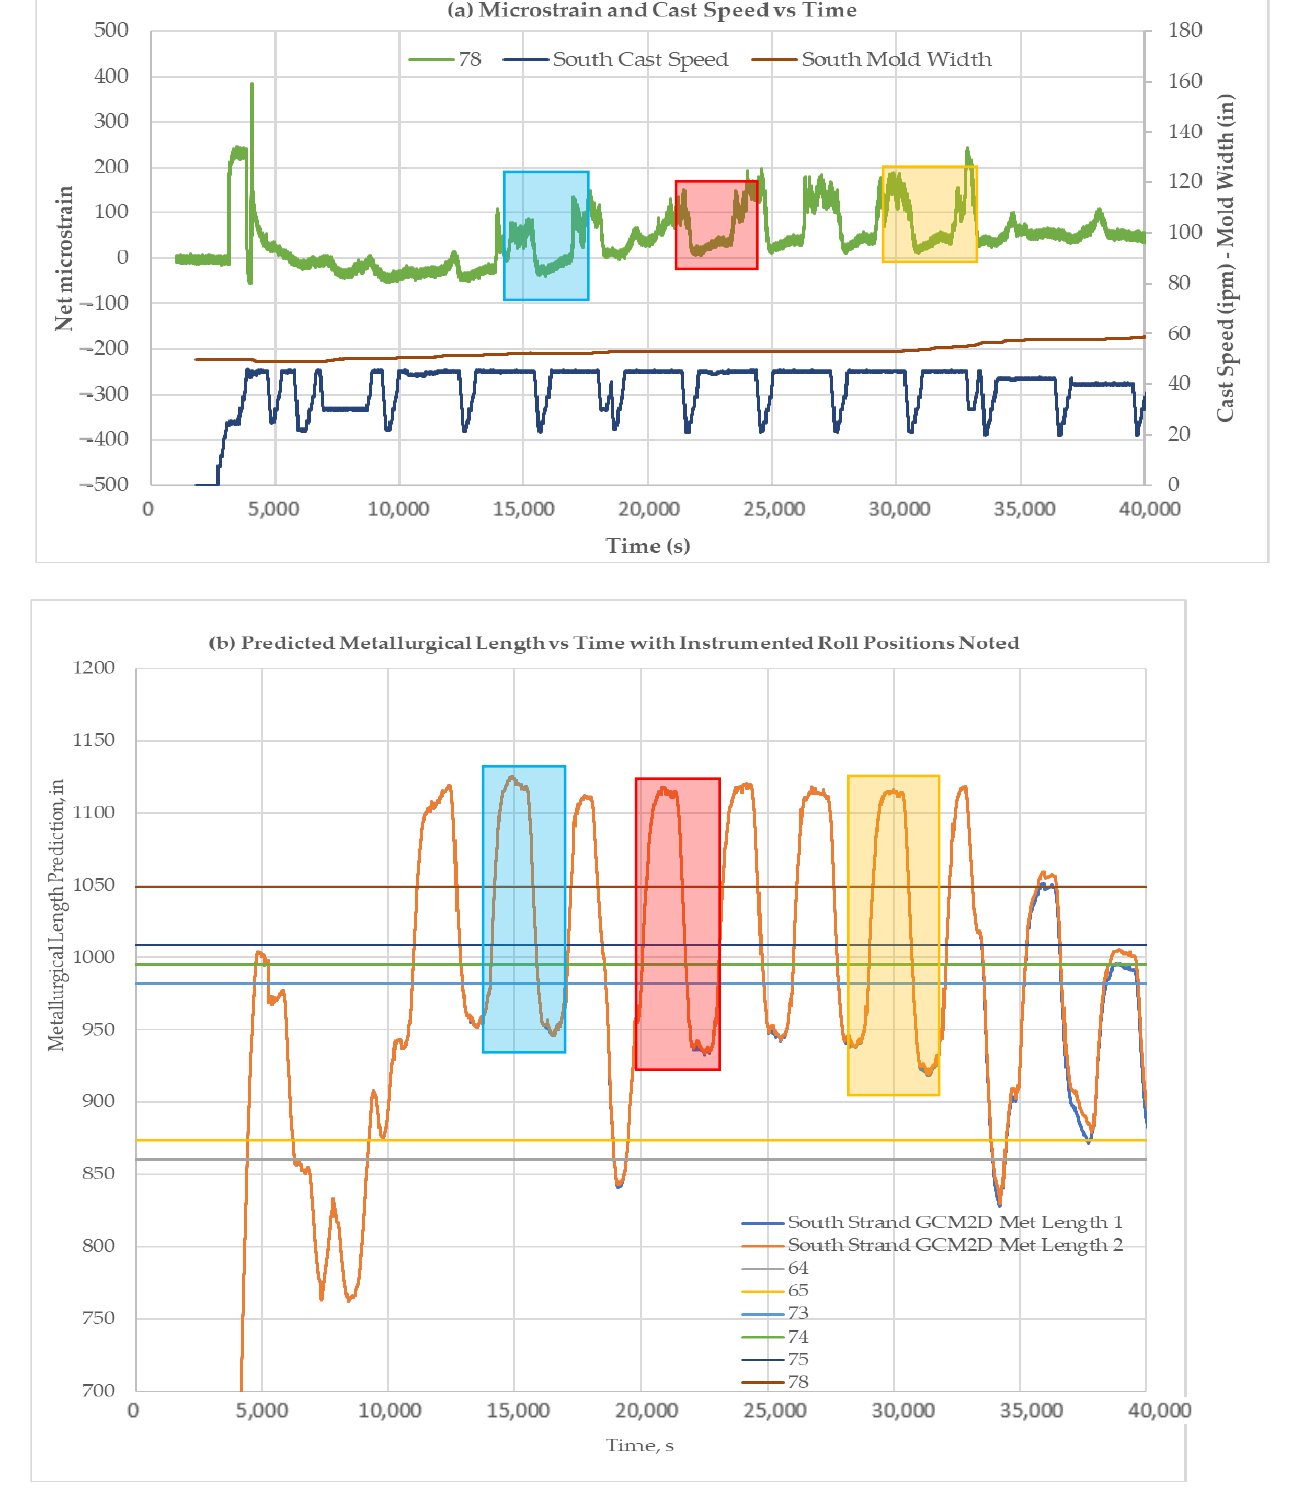
Figure 22. Liquid core position and corresponding net roll strains for the first 12 heats of the 20-heat cast sequence with liquid core locations highlighted for Roll-78. ( a ) Microstrain and cast speed is plotted against time. Three sections (highlighted by rectangles) were chosen to be compared with metallurgical length. ( b ) Predicted metallurgical lengths for different time periods. Strain comparison for sections highlighted in Figure 23a with metallurgical lengths.